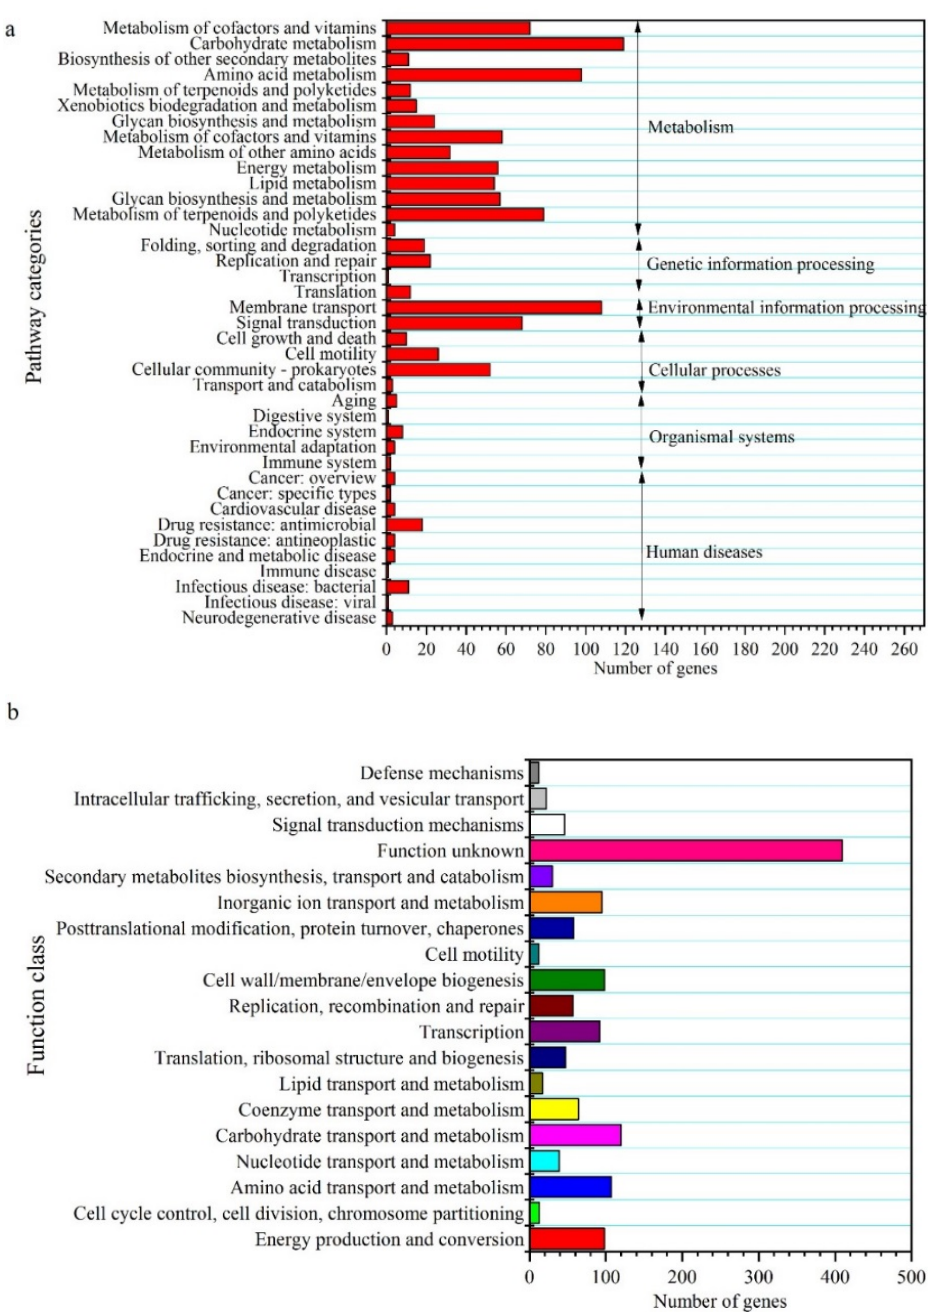
Figure 4. KEGG functional classification ( a ) and COG functional classification ( b ) of the differential genes. The differential genes between fructose were used as the carbon source in the modified DSMZ 879 medium (control) and cane molasses alone was used as the fermentation